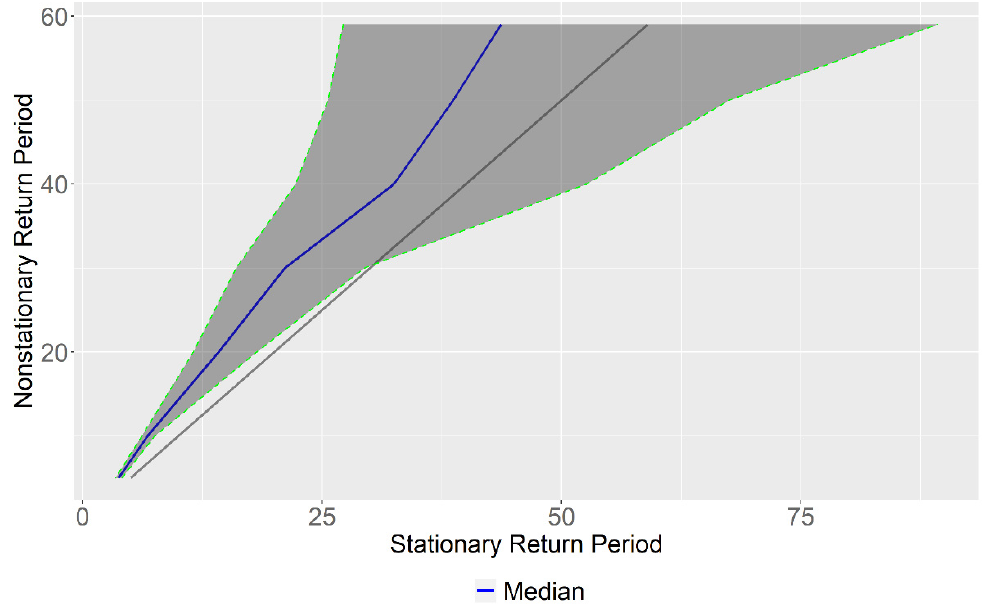
Figure 12. The uncertainty with 50% credibility intervals between LN C -3 and LNs models.